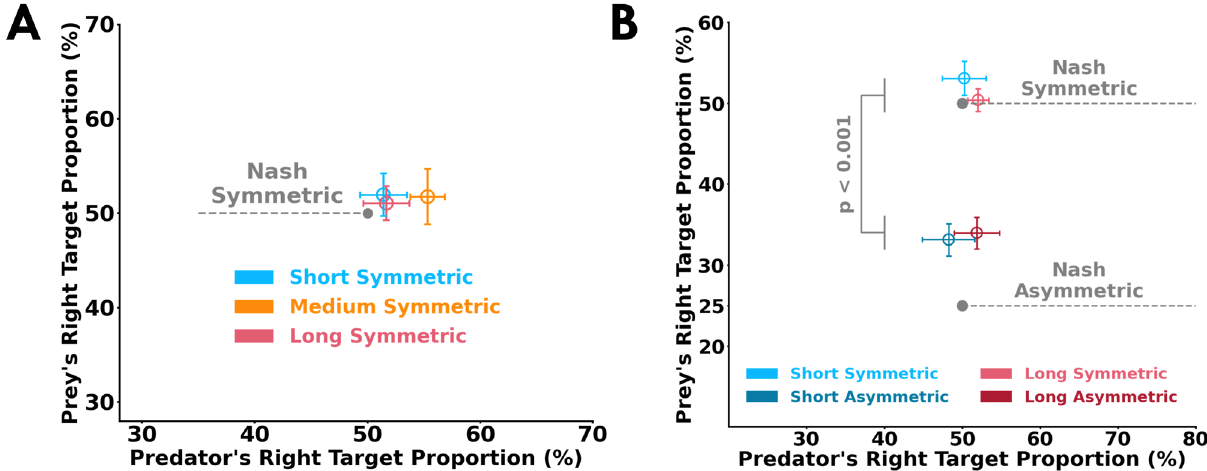
Figure 6. Target selection proportions. ( A ) Average right target proportion (%) of the predator ( x-axis ) and prey ( y-axis ) in Experiment 1. The right target selection proportions of the predator and prey were close to the Nash equilibrium solution for the symmetric reward structure (50% for both predator and prey). ( B ) Average right target proportion (%) of the predator ( x-axis ) and prey ( y-axis ) in Experiment 2. The Nash equilibrium solution (gray circles) for the symmetric (50% for both predator and prey) and asymmetric (50% for predator and 25% for prey) reward structures are shown in ( A ) and ( B ). Error bars represent ± 1 standard error. Across both experiments, the predator selected the right target in proportions close to 50%. As expected in the short asymmetric condition, the prey selected the right target in proportions that approached the Nash equilibrium solution. Unexpectedly and against our prediction, the prey target selection approached the Nash equilibrium solution in the long-asymmetric condition—even though they were utilizing sensory evidence of their opponent to select a target (see Fig.